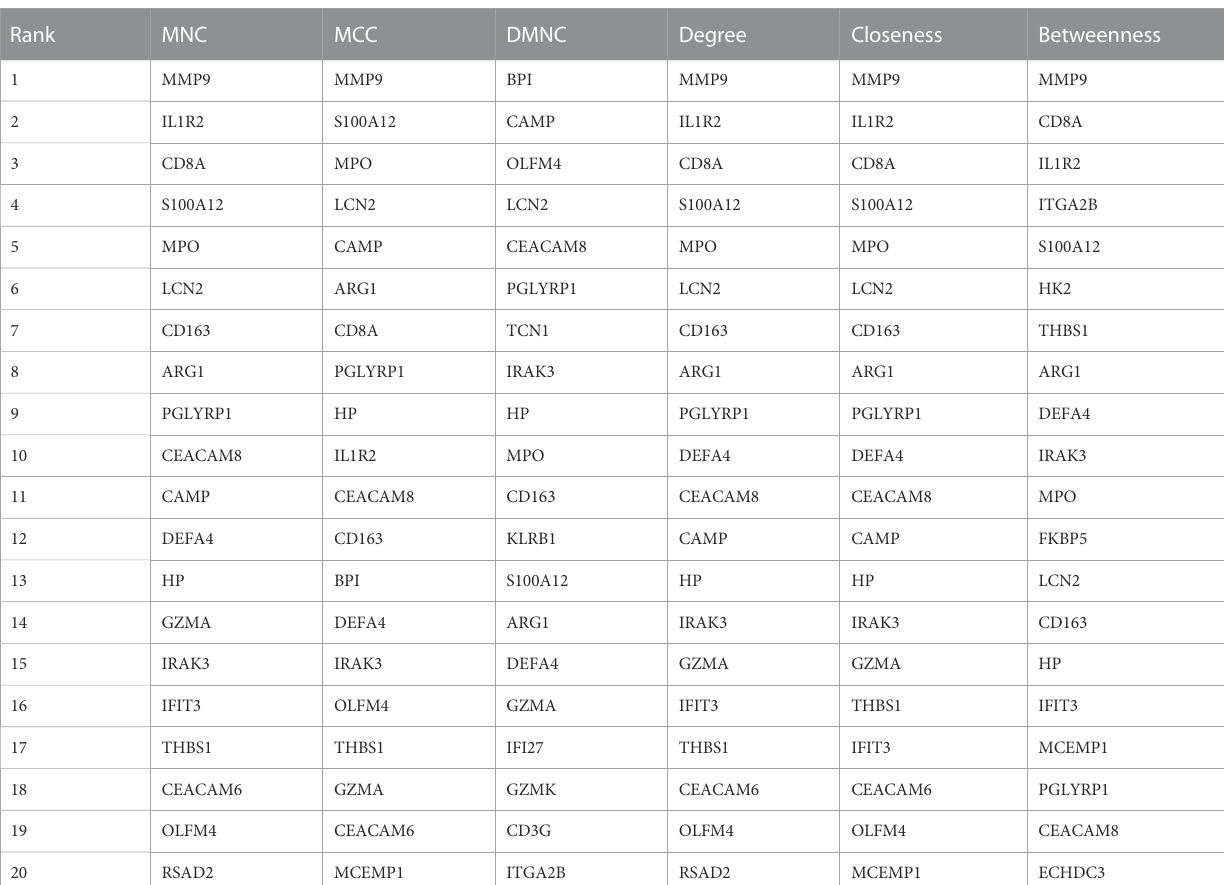
TABLE 3 The top20 genes identi fi ed by six different methods.